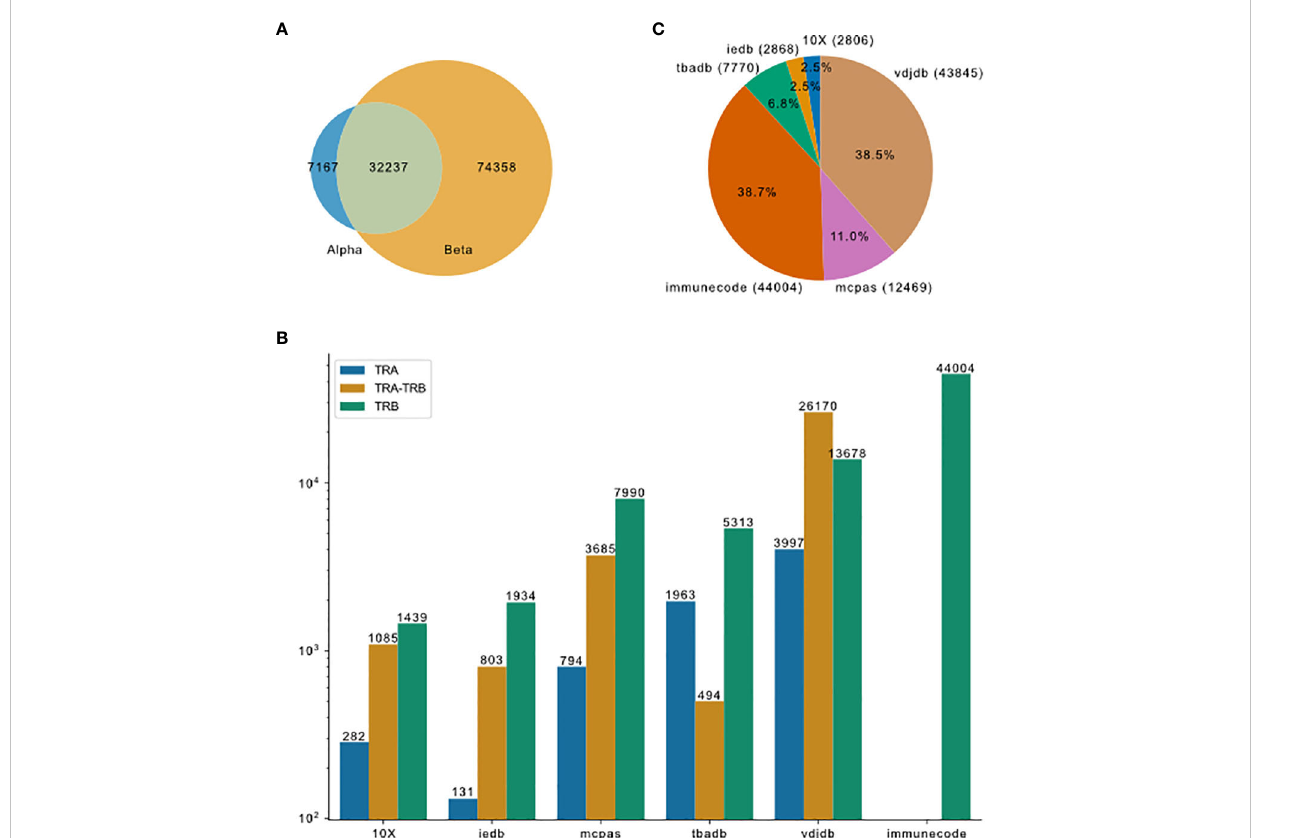
FIGURE 2 Overview of TCR-pMHC binding data merged from different resources. (A) Venn plot shows the overlap of entries that contain only TRA, paired chains or only TRB. The size of the ellipses correlate to the number of entries for each category. (B) Pieplot shows the composition of the merged database. Number of entries in each resource indicated in the parentheses. (C) TRA and TRB availability for the six major